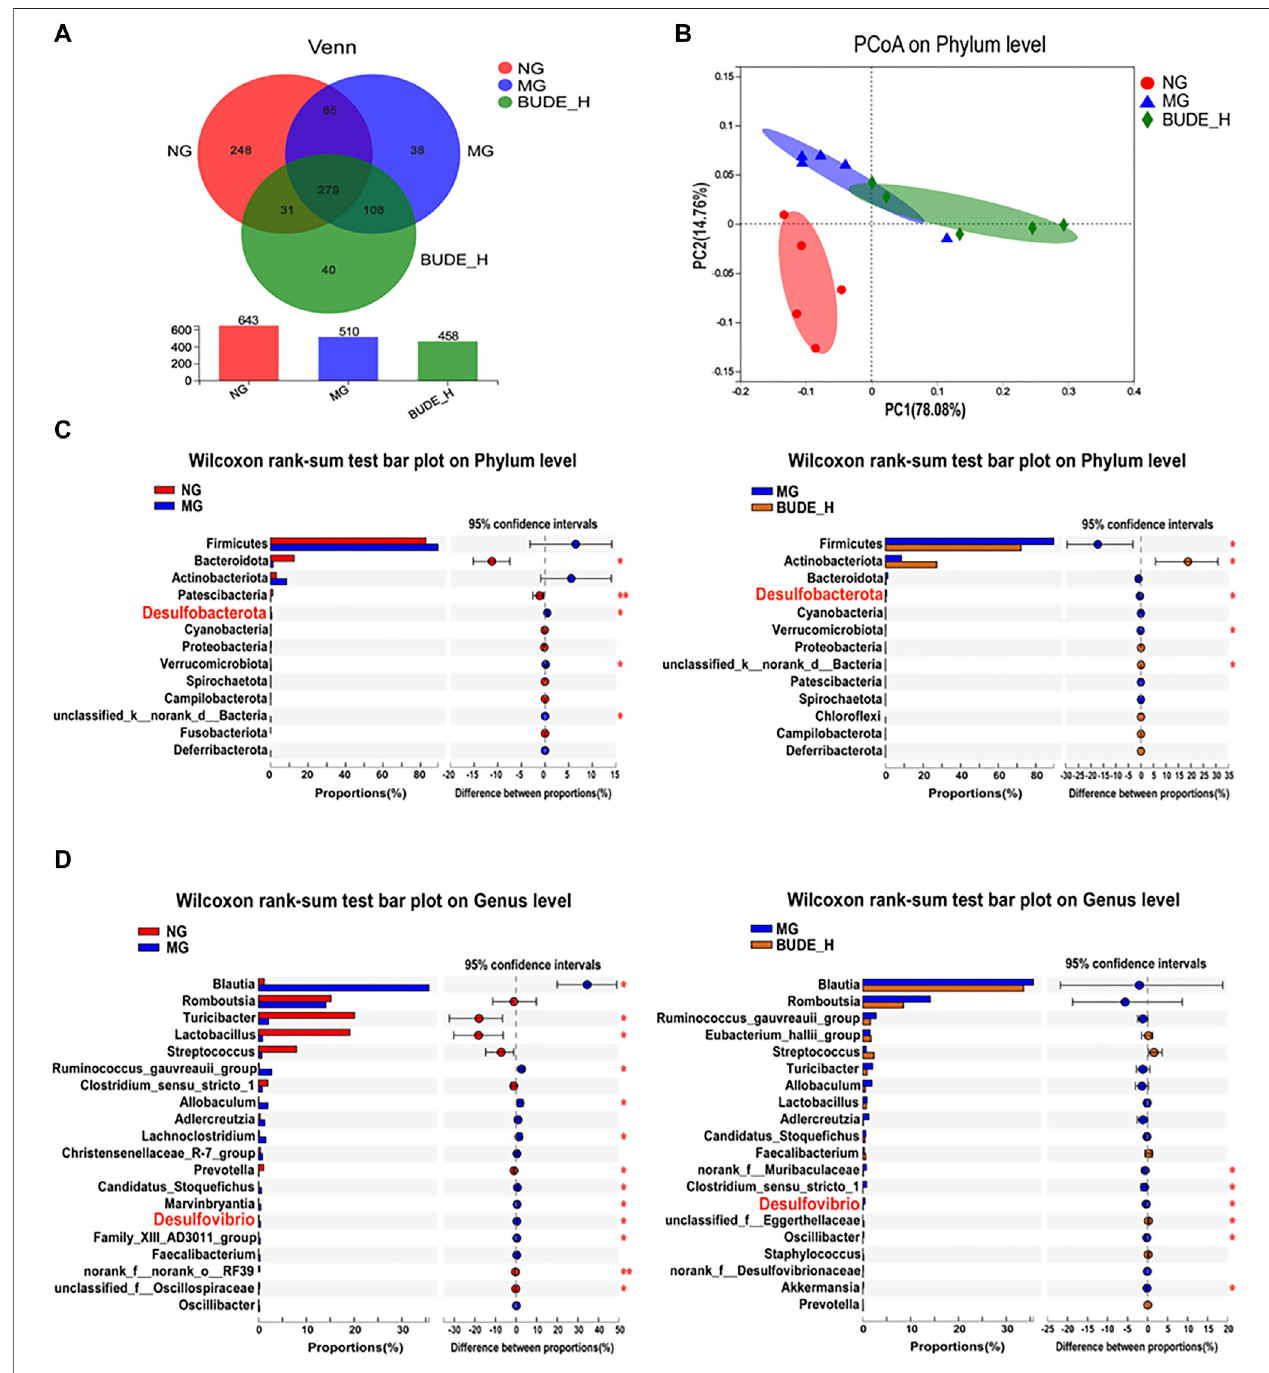
FIGURE 6 | Effect of BUDE on the intestinal fl ora. (A) Venn diagram. (B) PCoA analysis of phylum level in groups. (C) Analysis of the difference microbiota abundance between the NG, MG and BUDE-H at the phylum level. (D) Analysis of the difference of the top 50 of intestinal fl ora abundance between the NG, MG and BUDE-H groups at the genus level. * p < 0.05, ** p < 0.01, n (cid:2) 5.